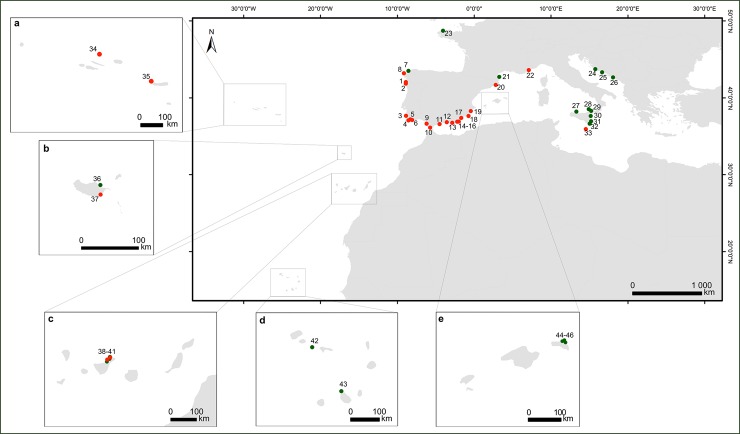
Geographical distribution of the Cystoseira samples
used in this study.Green dots represent GenBank sequences and the red dots data obtained in
this study. The boxes show the archipelagos of aMadeira,
bAzores, cCanary, dCape Verde and
eBalearics. Locations and sampling number marked as red
dots are: 1Moledo (n = 1);
2Areosa (n = 2); 3Odeceixe
(n = 1); 4Manuel Lourenço
(n = 4); 5Olhos de Água
(n = 9); 6Arrifes (n =
1); 7A Coruña (n = 4); 8Santa
Mariña (n = 2); 9Santibañez
(n = 2); 10El Mirlo (n
= 3); 11Calaburras (n = 1);
12Herradura (n = 1); 13Guardias
Viejas (n = 1); 14La isleta del Moro
(n = 2); 15El Playazo
(n = 2); 16Las Negras
(n = 1); 17La Serena (n
= 1); 18Cabo de Palos (n = 1); 19Santa Pola (n =
1); 20Blanes (n = 3); 21Cote Vermeille
(n = 2); 22Pointe I´lette
(n = 1); 23Santec (n =
2); 24Prvic Island (n = 1);
25Brac Island (n = 1);
26Dubrovnik city area n = 1);
27Capo Gallo (n = 1); 28Aeolian
Island (n = 2); 29Capo Milazzo
(n = 1); 30S. Maria la Scala
(n = 3); 31Marzameni (n
= 4); 32Capo Passero (n = 2);
33Xghajra (n = 1); 34Carapacho
(n = 1); 35Ponta dos Mosteiros
(n = 2); 36Porto da Cruz
(n = 1); 37Caniço (n =
2); 38Bajamar (n = 1); 39Mesa del
Mar (n = 4); 40Punta del Hidalgo
(n = 6); 41Tacoronte (n
= 1); 42Branco island (n = 1);
43Tarrafal Bay (n = 1); 44Cala
Viola de Llevant (n = 1); 45La Llosa d'en Patro Pere
(n = 1); 46Illots de Tirant
(n = 1); 47Cala Mica (n
= 2); 48Illa d'es Porros (n = 1). For
further information about the location of sample points, please refer to
the S1
Table.